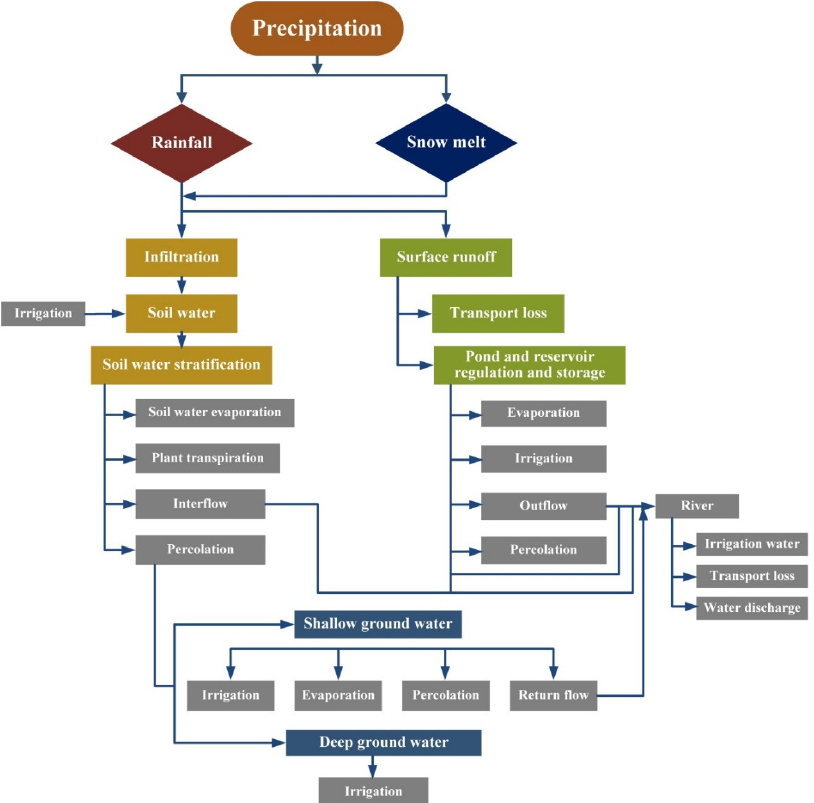
Figure 2. The dynamic simulation model of water quantity and quality in the Daqing River Basin.